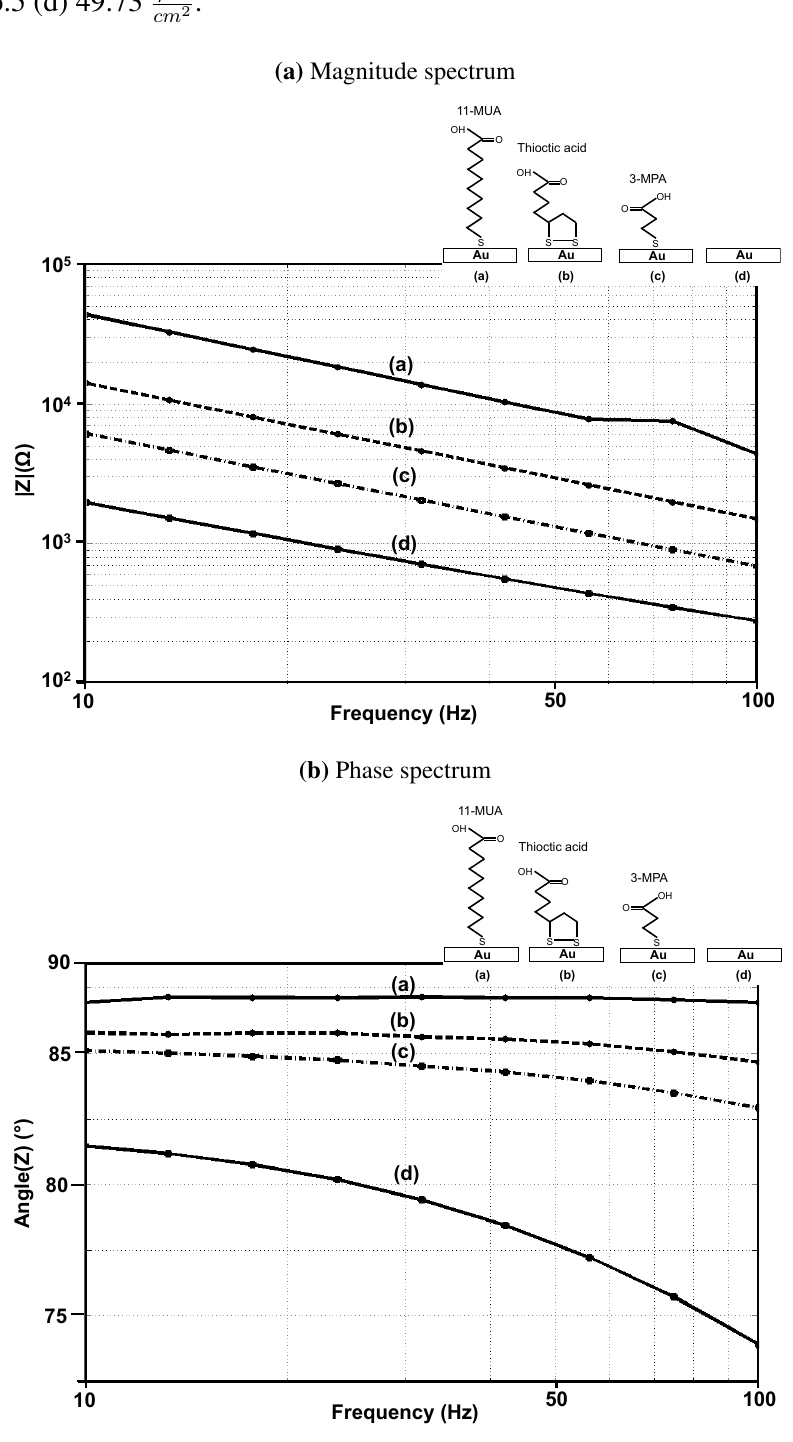
Figure 9. Experimental determination of the magnitude and phase spectrum of electrode-electrolyte system with different monolayers immobilized onto the gold